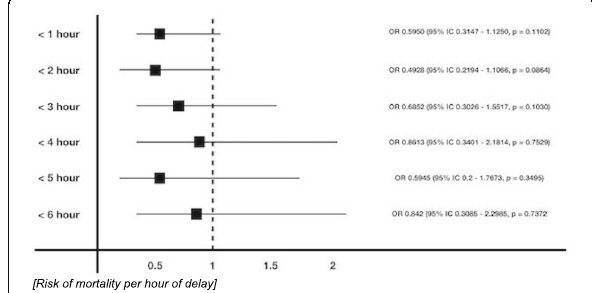
Fig. 1 (abstract 0260). Risk of mortality per hour of delay